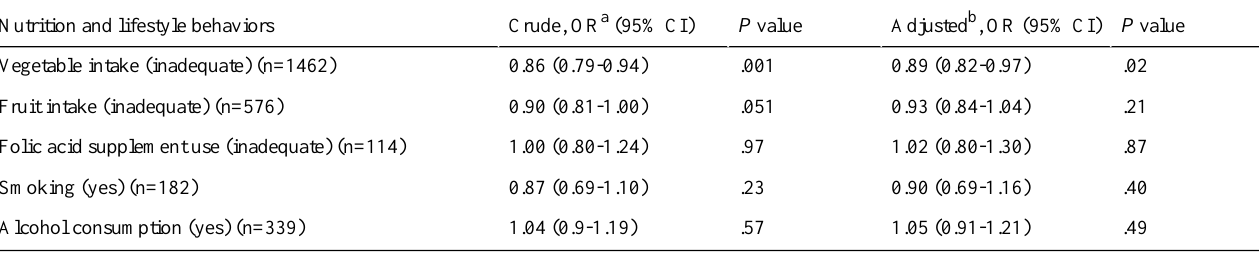
Table 4. The association between the neighborhood status score and improvement of inadequate nutrition and lifestyle behaviors after 24 weeks of coaching in all women who scored inadequately at the start of the mobile health